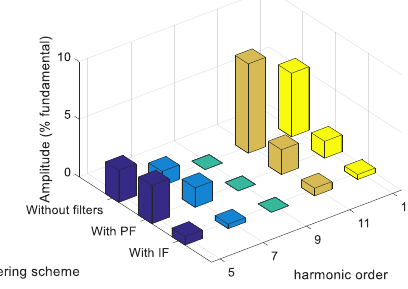
Figure 11. Current spectra at the 380 V bus.